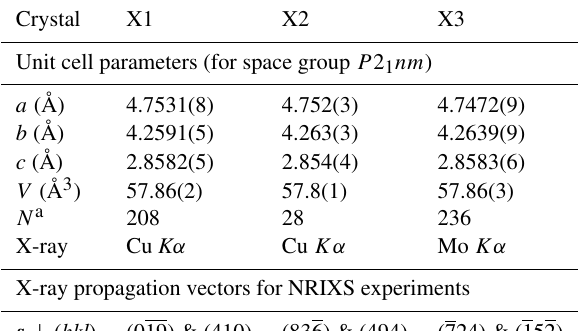
Table 1. Unit cell parameters of δ -(Al,Fe)OOH single crystals and X-ray propagation vectors for NRIXS experiments. Crystal X1 X2 X3 Unit cell parameters (for space group P 2 1 nm